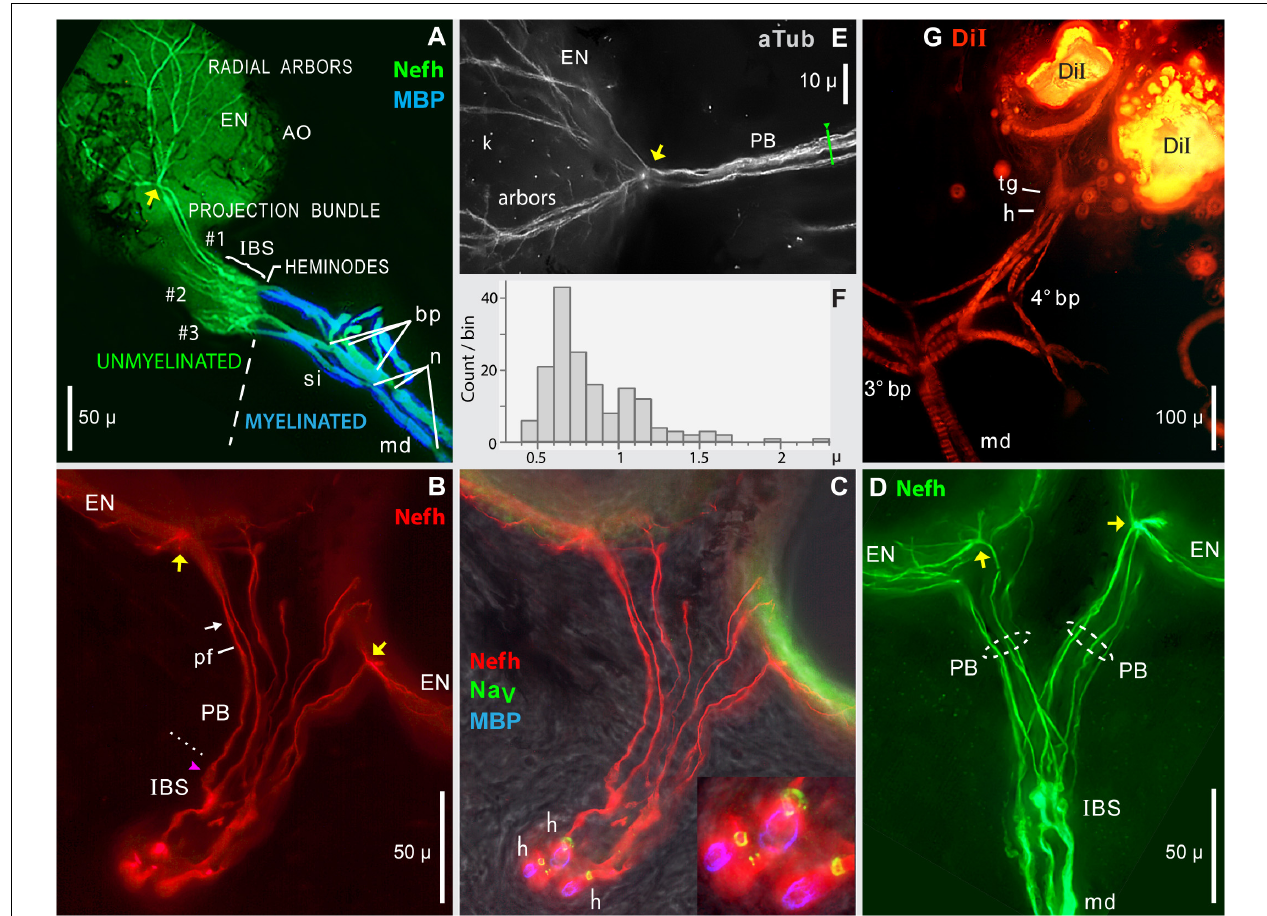
FIGURE 7 | Projection bundles, and transitions to myelinated arbors. (A–E) Frozen sections (50 µ ) of skin from the rostrum base were immunolabeled to reveal the innervation of ampullary organs by ALLn sensory neuron processes labeled by anti–neurofilament-H (Nefh) or anti–acetylated α -tubulin (aTub). Sheaths on afferent dendrites were revealed by anti–myelin basic protein (MBP). Heminodes (h) were labeled by anti–pan Na V (blue), or corresponded to the distal-most edge of MBP+ labeling. yellow arrows, Focal contact sites of projection bundle fibers, on the basolateral face of AOs. (A) Overview of the afferent innervation of ampullary organs (AO). The dashed line marks the transition from myelinated dendrites (md, blue) to unmyelinated arbors (green), at inline branching structures (IBS) where afferents divided into parallel projection bundles (#1, #2, #3) of submicron unmyelinated neurites, which diverged into radial arbors shown partially on one AO, to innervate receptor cells in the electrosensory neuroepithelium (EN). Projection bundles #2 and #3 were truncated; the AOs they innervated were outside the section. bp, Branch points. n, Narrowed nodes of Ranvier. si, Short internodes. (B,C) Projection bundles (PB) connected IBSs to ENs. (B) dotted line, Transition from IBS to projection fibers (pf). (cid:74) , Globular IBS substructure which generated one projection fiber. arrow, Site of Figure 8A . (C) Heminodes (h) were labeled (inset) as rings of anti–pan Na V labeling (green) encircling three of the afferents, confirmed by the start of MBP labeling (blue) on myelinated dendrites (md). (D) Separate projection bundles (PB, dashed ovals) connected one IBS complex to two ampullary organs (AO). md, Large-diameter myelinated dendrites. (E) In this enlarged image of a contact site (yellow arrow), fibers in a projection bundle approached an AO, then radiated on its electrosensory neuroepithelium (arbor, EN); blue anti–aTub fluorescence. Kinocilia (k) of receptor cells were also labeled by anti–aTub. (F) Histogram of widths of 162 different projection fibers, from 20 images including (A–E) , each resampled 4x. (G) DiI tracing of distal afferent branches by transcellular retrograde diffusion of lipophilic DiI, from small crystals placed on the EN of two adjacent ampullary organs. Migrating proximally, DiI tracing revealed candidate terminal glia (tg), sites where myelination began at presumed heminodes (h), and third- or fourth-generation branch points (3 ◦ bp, 4 ◦ bp) of myelinated dendrites (md), which appeared banded due to external melanin (Russell et al., 2019). The 4 ◦ branch point had three progeny branches. (A,G) 10x 0.3 NA lens. (B–D) 40x 0.7 NA lens. (E) 40X 0.75 NA water